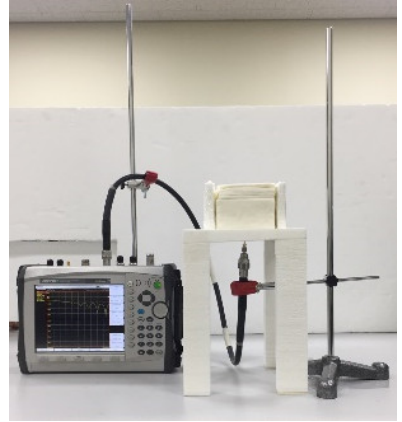
Figure 9. Test setup for S 11 measurement.